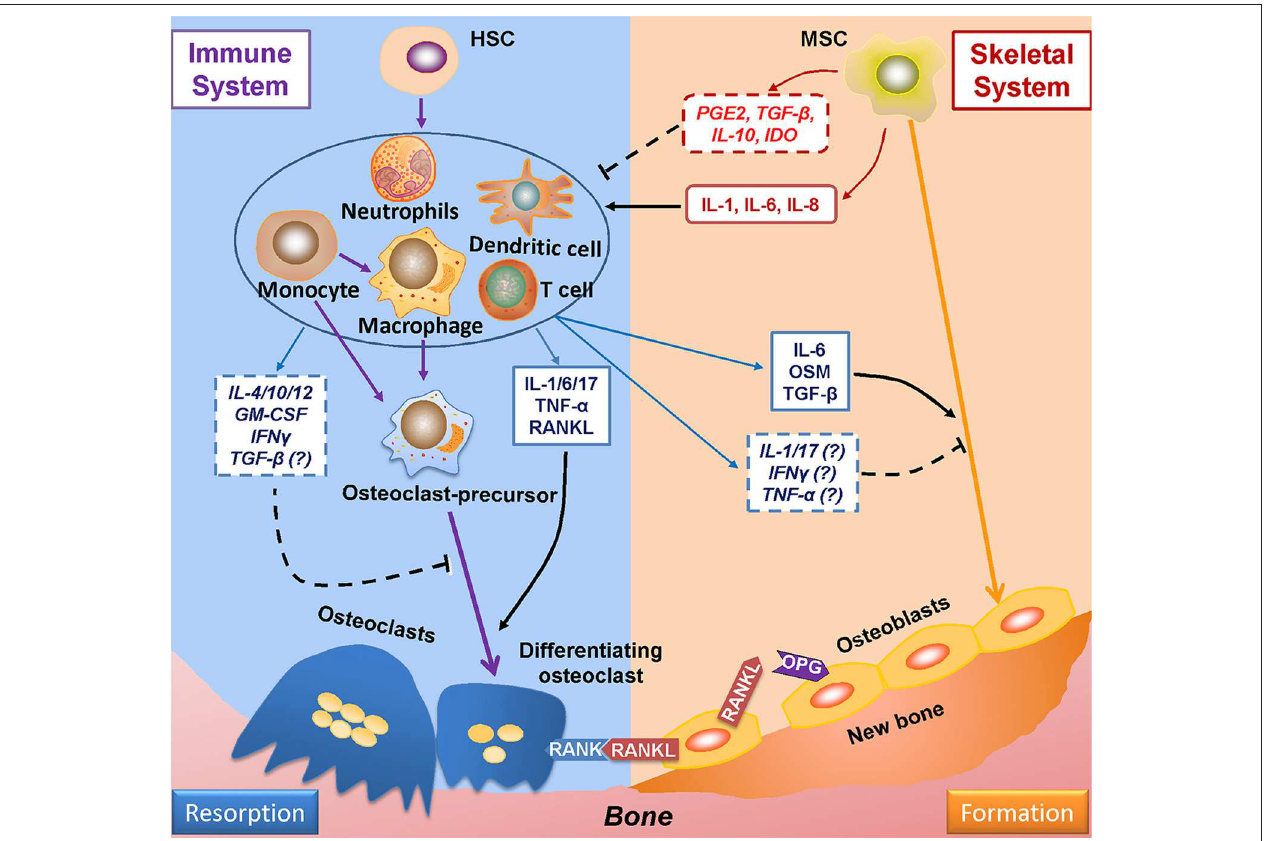
FIGURE 2 | Mutual regulations between the immune and skeletal systems. The two major players in bone remodeling—osteoclasts and osteoblasts are coupled through the RANKL-RANK-OPG axis: osteoblasts-derived RANKL combines with its ligand RANK in osteoclasts and plays an indispensable role in osteoclastogenesis; OPG (which is also derived from osteoblasts) reduces osteoclastogenesis by impairing the RANKL-RANK signaling. The immune system greatly takes part in osteoclastogenesis by producing RANKL; also, the immune-related factors either affect pre-osteoclasts, or interacts with osteoblasts to induce RANKL production to regulate osteoclastogenesis. The immune-derived regulators also affect the process of osteogenesis. On the other hand, the progenitor cells of the skeleton system—MSCs suppress immune response either by cell to cell intact or by secreting functional regulators; whereas under certain conditions, MSCs upon TLR4 stimulation secret factors which induce immune response. RANKL, receptor activator of nuclear factor factor-kappa B ligand; RANK, receptor activator of nuclear factor-kappa B; OPG,